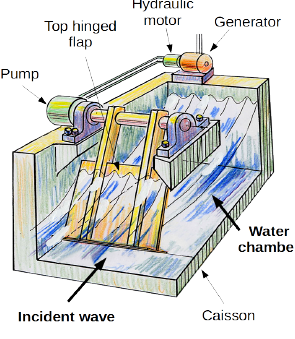
Figure 1. Concept of the “Pendulor” device